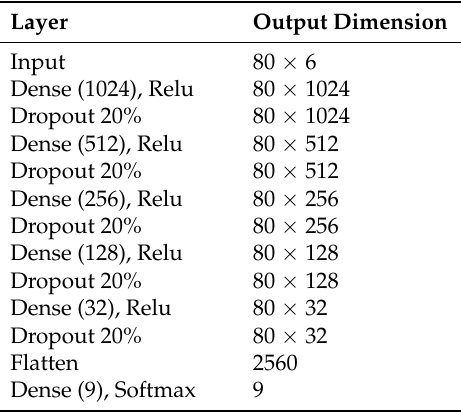
Table 7. Layers DNN (frame size =